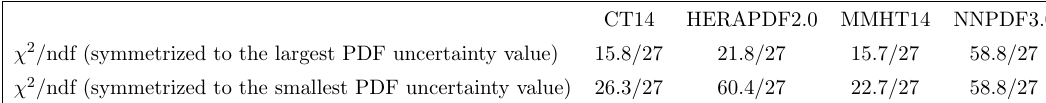
Table 11 . Overall goodness-of-(cid:12)t per number of degrees of freedom, (cid:31) 2 /ndf, among the 28 LHC experimental measurements of W + , W (cid:0) , and Z boson cross sections and the corresponding theo- retical predictions obtained with the four di(cid:11)erent PDF sets for their default (cid:11) s ( m Z ) = 0 : 118 value. The (cid:12)rst (second) row lists the results obtained symmetrizing the PDF uncertainties of the cross sections obtained with the CT14, HERAPDF2.0, and MMHT14 sets to the largest (smallest) of their respective